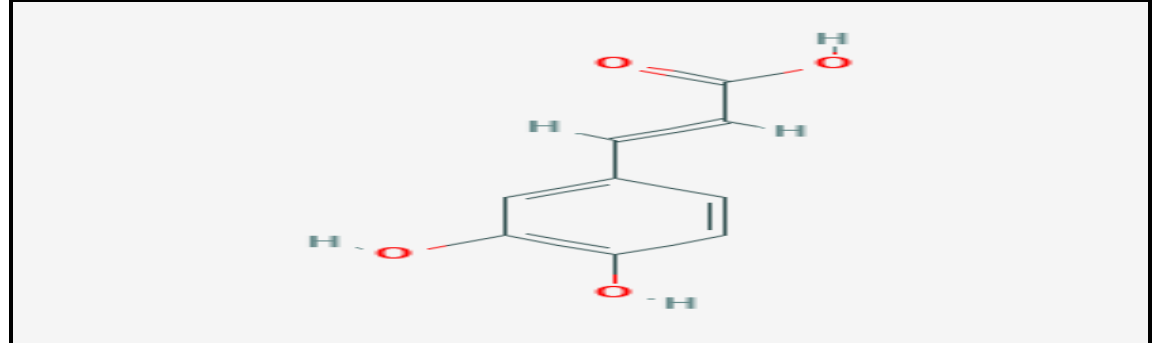
dihydroxycinnamic) caffeic acid, and molecular ion peak m/z 179.3 [M-H]for caffeic acid.